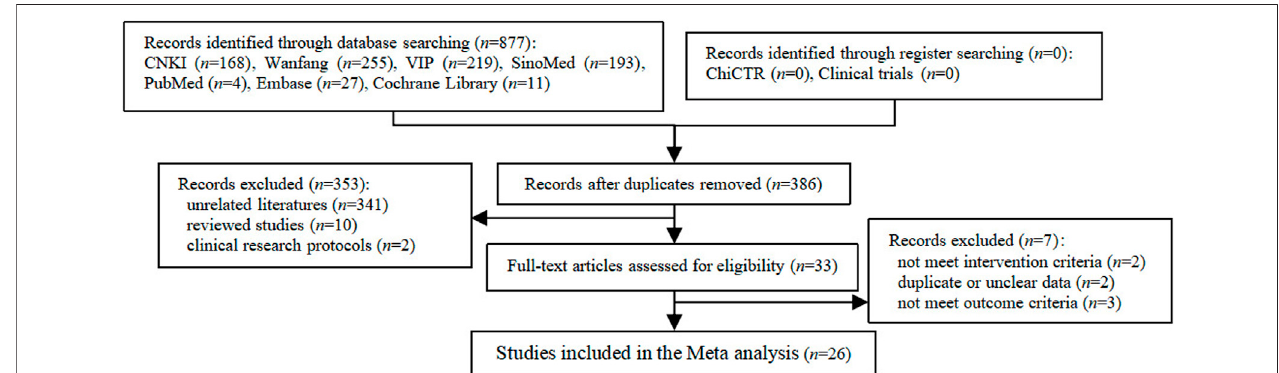
FIGURE 1 | Flow chart of study